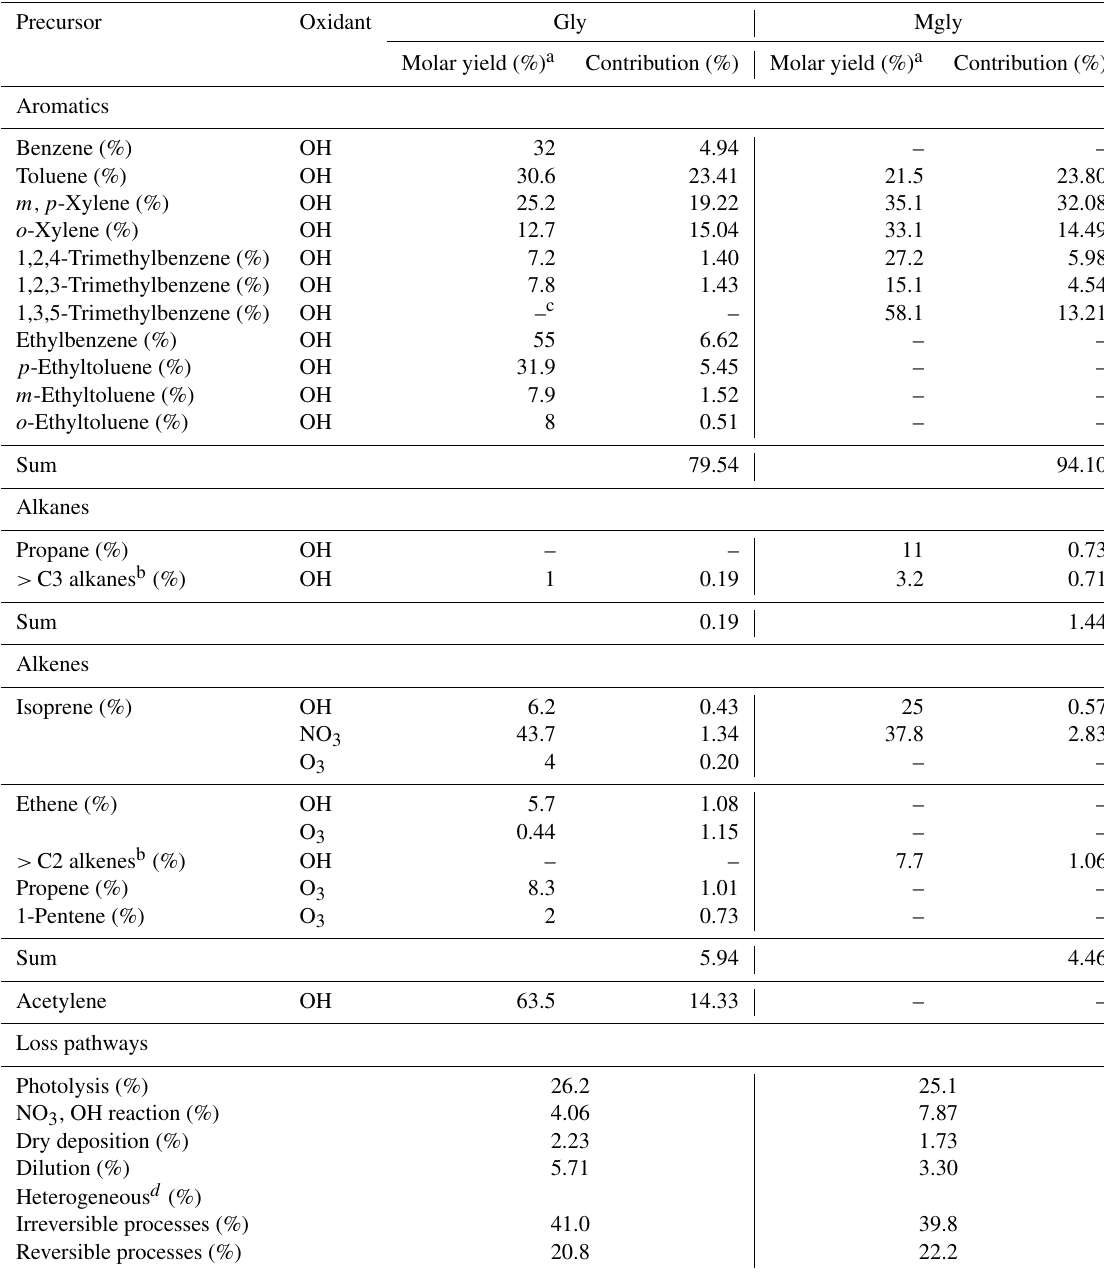
Table 2. Production and destruction of Gly and Mgly from model simulation in the daytime. Precursor Oxidant